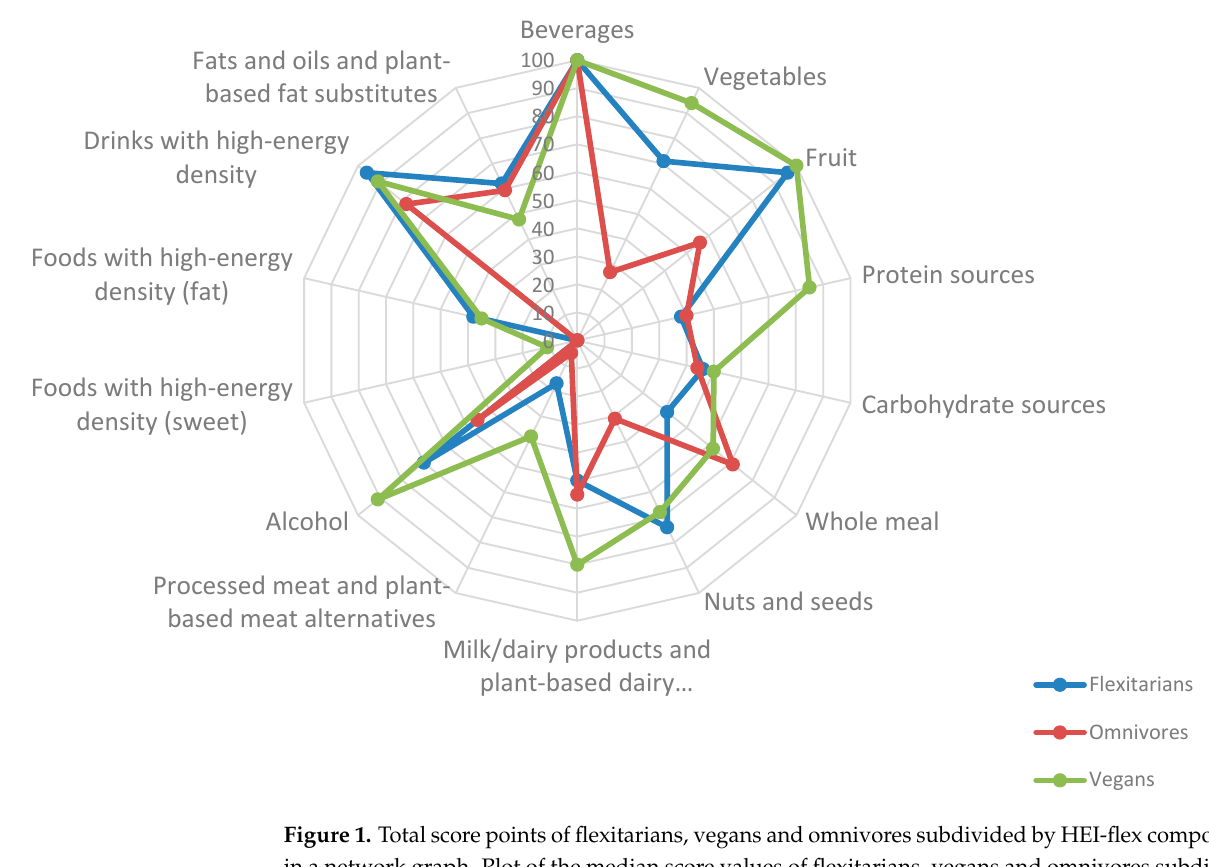
0.184 FX = flexitarians, V = vegans, OMN = omnivores. f = female, m = male. n = number of participants. SP = score points; V max = 100 SP, V min = 0 SP. Normally distributed data are shown as mean Ø ± SD and not normally distributed data as median 𝑥(cid:3556) with 25th, 75th percentile. The difference between groups were analyzed using either univariate ANOVA for normally distributed data or the Krus- kal–Wallis test for not-normally distributed data; post hoc Bonferroni correction ( α adj = 0.0167). Dif-